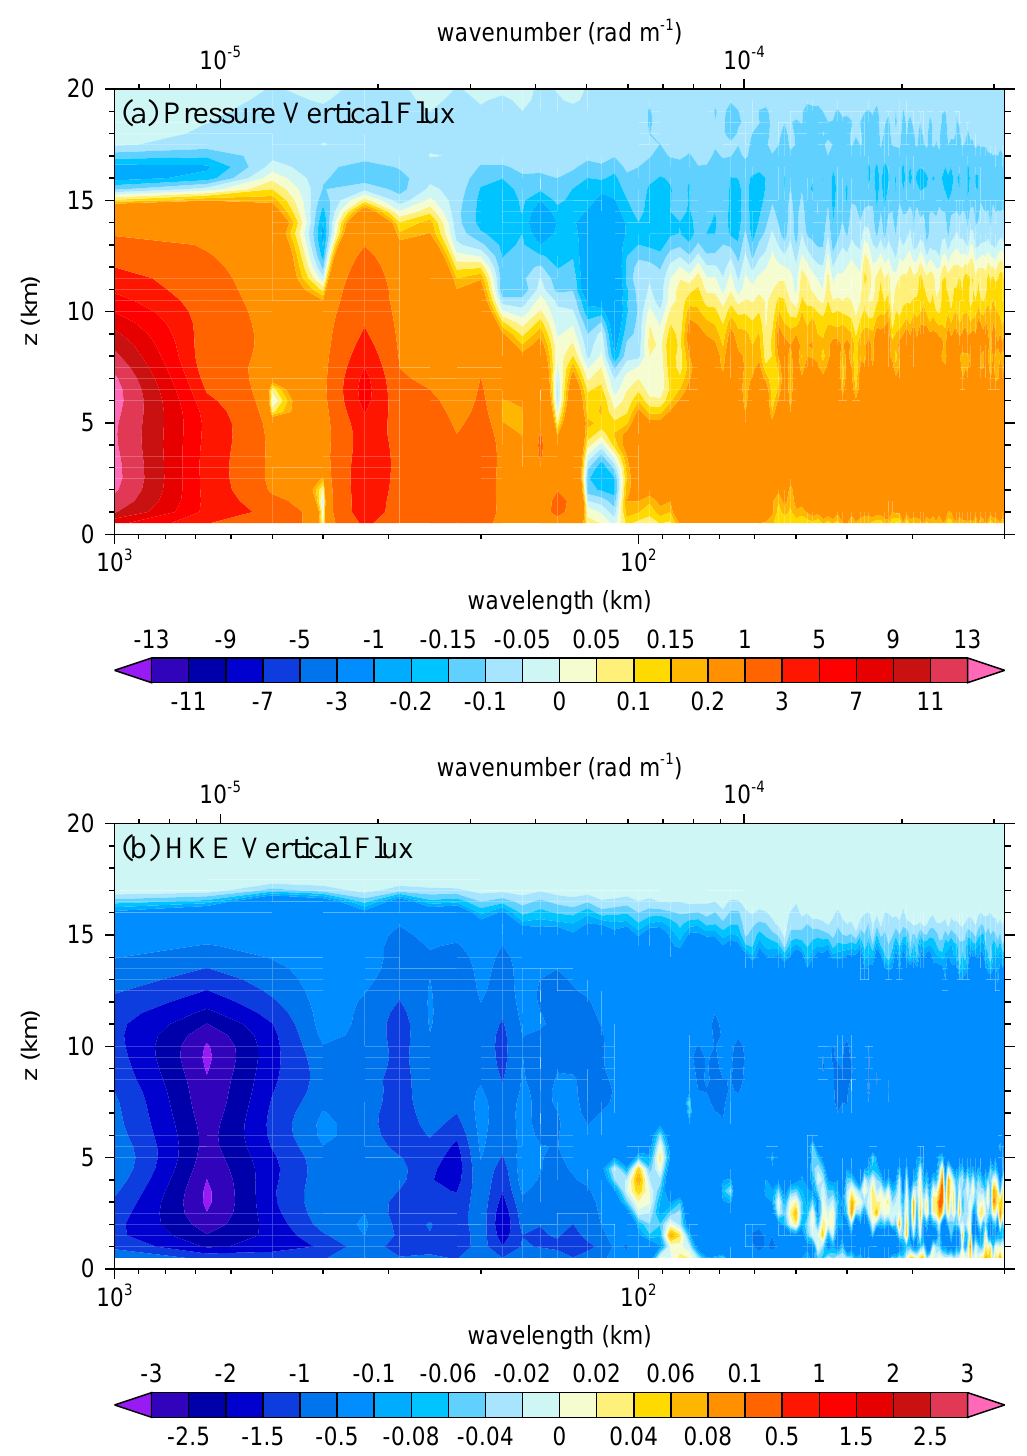
Figure 8. Horizontal wavelength–height distribution of ( a ) pressure vertical flux and ( b ) HKE vertical flux averaged in time over the intensification period (m 2 s − 3 kg m − 2 ). F The vertical distribution of for λ h < 100 km ( k h > 2 π × 10 − 5 rad m − 1 ) is similar to that for 400 ↑ p < λ h < 1000 km (2 π × 10 − 6 < k h < π /2 × 10 − 5 rad m − 1 ), except that the boundary height between positive F and negative reduces to z = 13 km; namely, the highest source region of the waves drops in ↑ p height. For wavelengths (wavenumbers) slightly longer (smaller) than 100 km (2 π × 10 − 5 rad m − 1 );